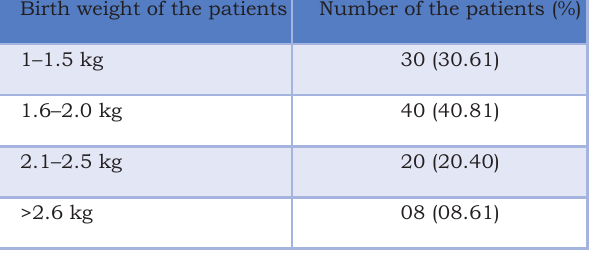
Table 1: Birth weights of patients Birth weight of the patients Number of the patients (%)